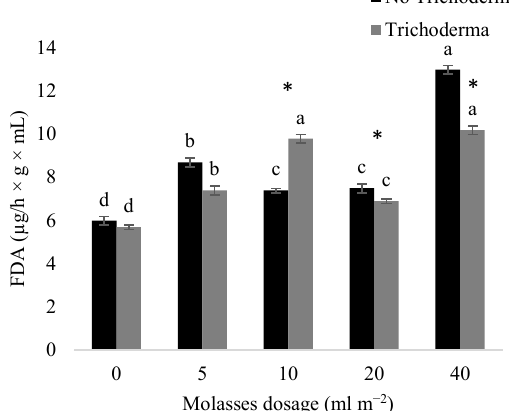
Figure 1. Relationship between the dry shoot weight (DSW) ( A ), fresh root weight (FRW) ( B ), galling index ( C ), and number of eggs + J2 plant − 1 ( D ) with increasing molasses dosage (0, 5, 10, and 20 mL m − 2 ) alone or in combination with Trichoderma asperellum T34 inoculated before and at transplanting the susceptible tomato cv. Bodar in 3 L pots and inoculated with 1J2 cm − 3 of Meloidogyne incognita .